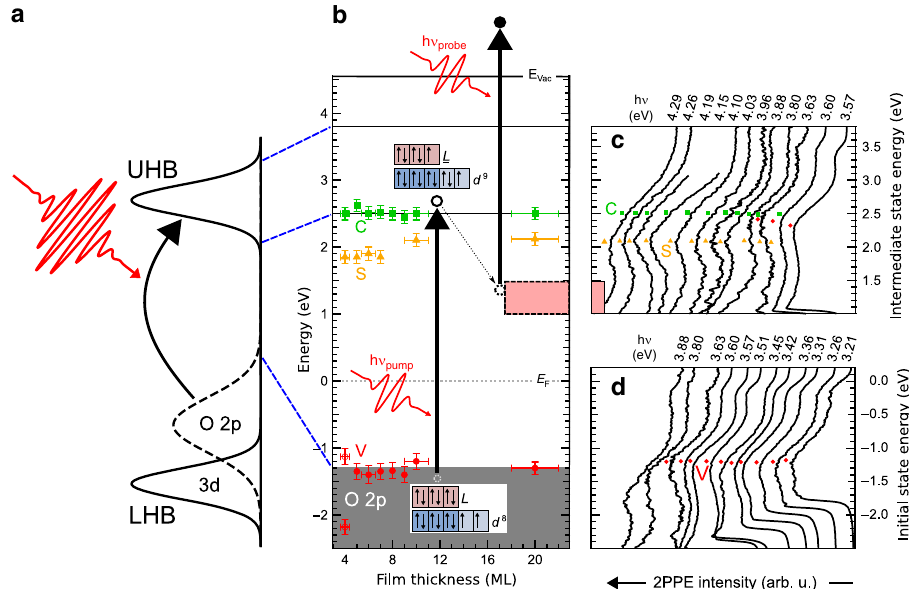
Fig. 1 Two-photon photoemission of NiO. a Schematics of photoexcitation in an ideal charge-transfer insulator. LHB (UHB): lower (upper) Hubbard bands formed by the 3 d electrons; O 2 p : oxygen valence bands. b Electronic structure of ultrathin NiO fi lms on Ag(001) with a thickness from 4 to 20 ML. Black arrows illustrate the pump ( h ν pump ) and probe ( h ν probe ) processes in time-resolved 2PPE. The relevant electronic states are: d 8 L ground states (V, bottom), photoexcited d 9 L states of the UHB (S and C, top), as well as photo-induced in-gap states associated with the THz oscillations (red fi lled). Red boxes of L ( L ) in the insets indicate the ligand 2 p states without (with) a photo-hole, whereas dark (light) blue boxes represent the t 2g ( e g ) orbitals of the 3 d states. c , d 2PPE spectra of 10 ML NiO fi lms for variable photon energies h ν pump = h ν probe as indicated above the spectra (laser pulse energies vary between 2 and 50 μ J/cm 2 depending on the photon energies h ν